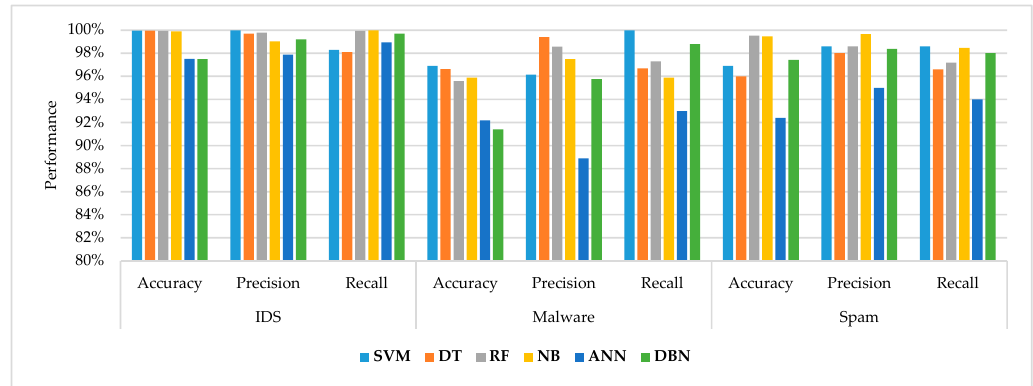
Figure 5. A Performance Evaluation of Machine Learning Techniques.